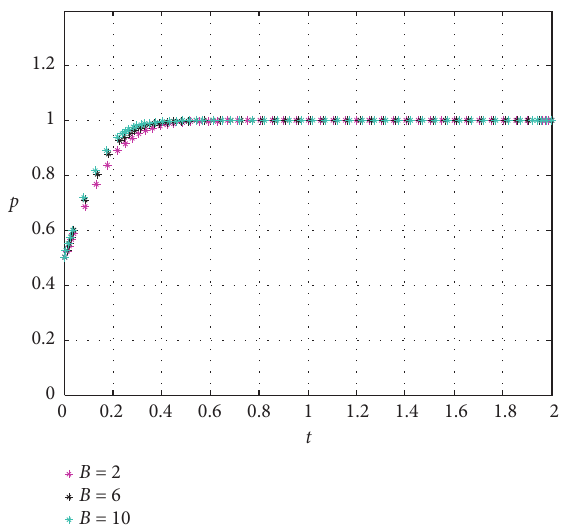
Figure 15: Evolutionary trajectory of owners’ behavior under different B